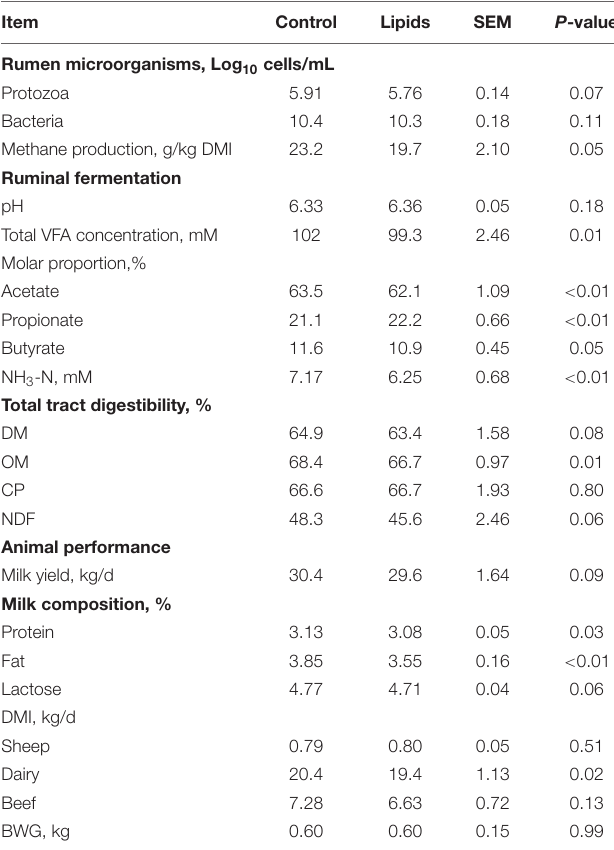
TABLE 5 | Effects of lipids on ruminal microorganisms, methane production, total tract digestibility, ruminal fermentation, and animal